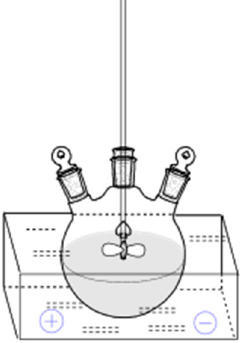
Figure 1. Experimental reaction device. Table 1. Experimental reaction conditions.